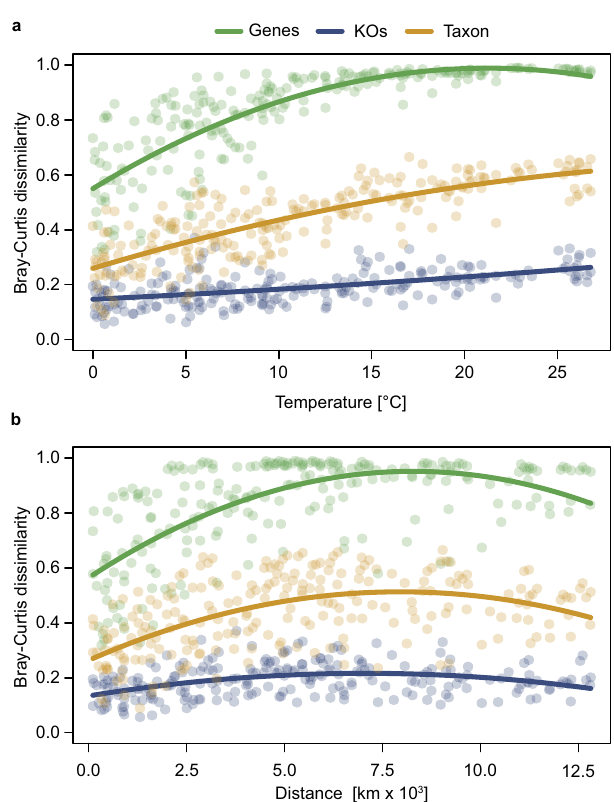
Fig. 5 Bray – Curtis dissimilarity relationships of species, KO, and nr gene pro fi les of the AOM for distance and temperature. a Relationship between Bray – Curtis dissimilarity of taxonomic ( r 2 = 0.65, p < 0.001), KO ( r 2 = 0.29, p < 0.001) and gene ( r 2 = 0.69, p < 0.001) pro fi les to temperature difference. b Geographical distance of taxon pro fi le: r 2 = 0.30, p <0.001; KO pro fi le: r 2 = 0.15, p < 0.001; gene pro fi le: r 2 = 0.45, p <